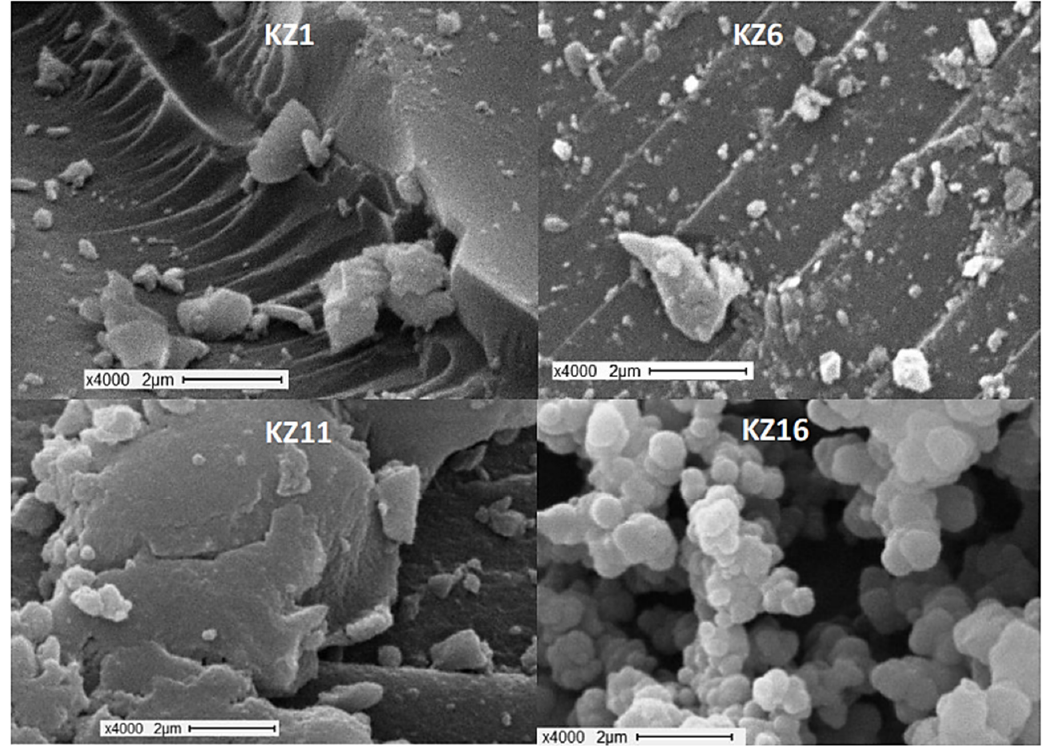
Figure 3. SEM micrographs of synthesized silica-based solid by acid (KZ1, KZ6 and KZ11) and alkali (KZ16) hydrolysis. Magnification ×4000 (scale bar: 2 µm).